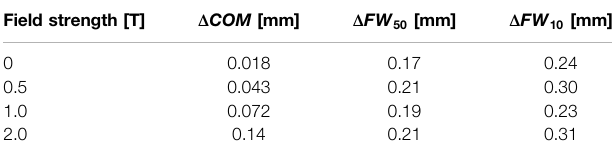
TABLE 1 | Comparison of MonteRay against Fluka for a 200 MeV proton beam incident on water with different homogenous magnetic fi elds applied perpendicular tothe beam. The maximum differences inthe COM ( Δ COM ) , FWHM ( Δ FW 50 ) and FW10%M ( Δ FW 10 ) across all depths up to the BP are